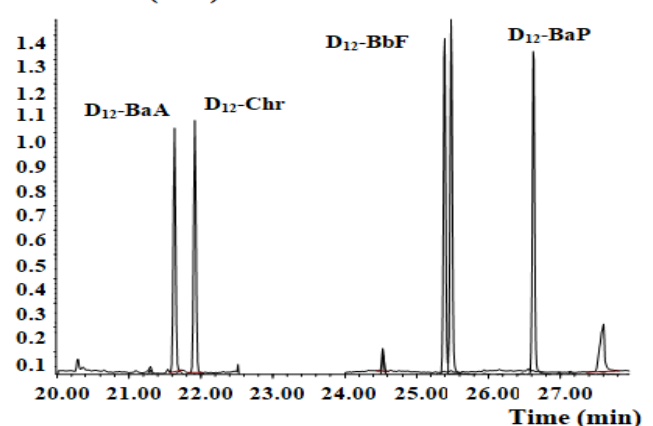
Figure 3. Mass chromatogram of the blank test. Three concentrations of PAH4 (2.0 µ g/kg, 10.0 µ g/kg, and 20.0 µ g/kg) were